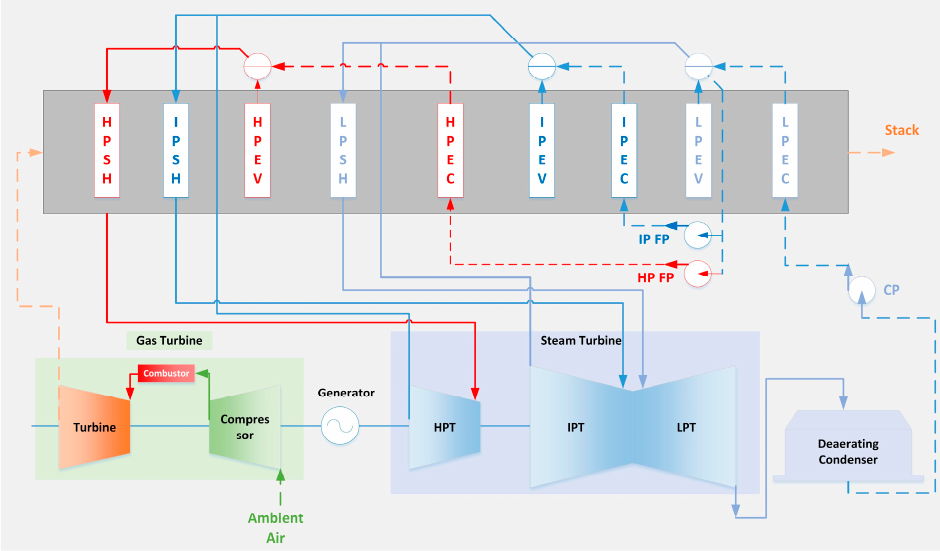
Figure 3. Schematic of the single-shaft CCPP. HP—high-pressure turbine, IP—intemediate-pressure turbine, LP—low-pressure turbine, SH—superheater, RH—reheater, EV—evaporator, FP—feed water pump, RP—recycle pump, CP—condensate pump.